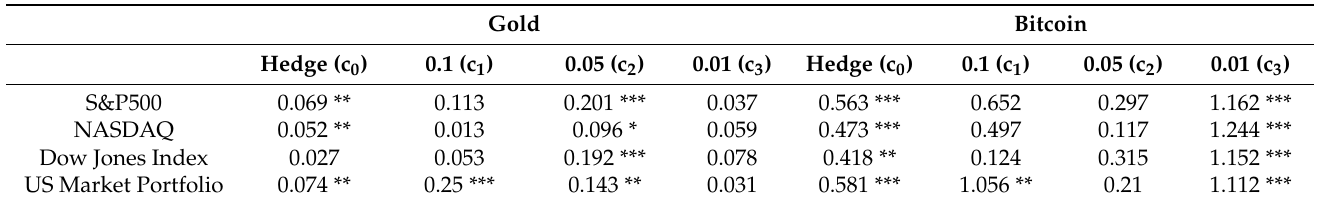
Table 4. Estimated Parameters for Safe Haven and Hedge Testing for gold and Bitcoin from October 2017 to February 2021. * Represents 90% confidence level; ** represents 95% confidence level; *** represents 99% confidence